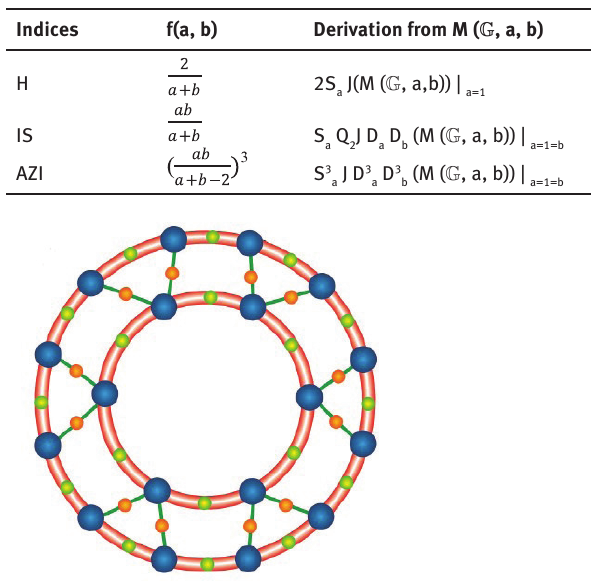
Table 2: Relation between M-polynomial and